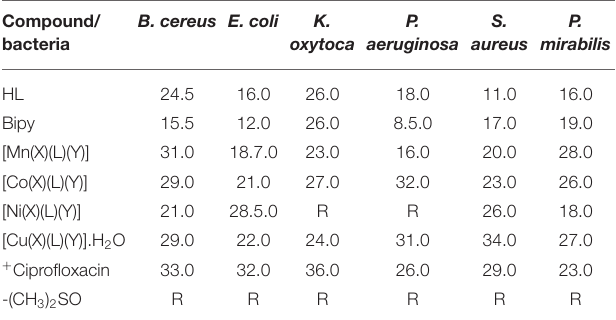
TABLE 2 | Antibacterial data of HL, 2,2 ′ -bipy and their heteroleptic complexes. Compound/ bacteria